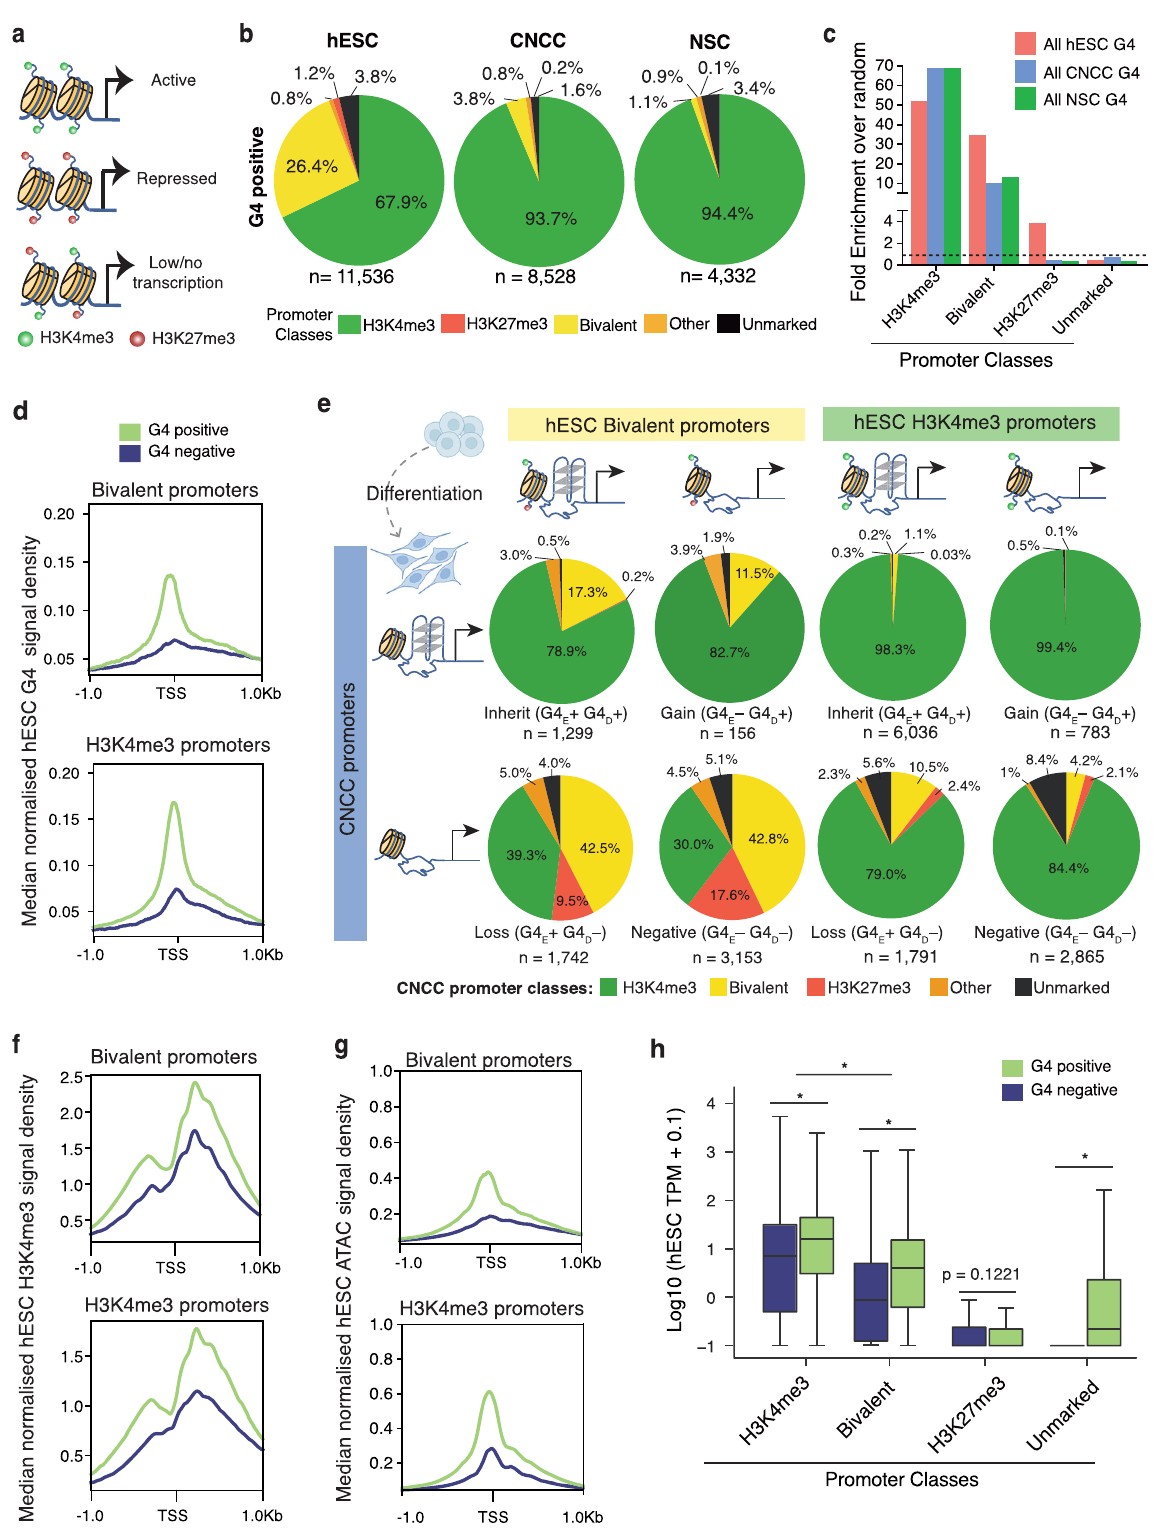
with a fl uctuating environment e.g during cellular differentiation. While we also observed transcriptional stabilisation for genes that Gene Ontology (GO) enrichment analysis for genes that are